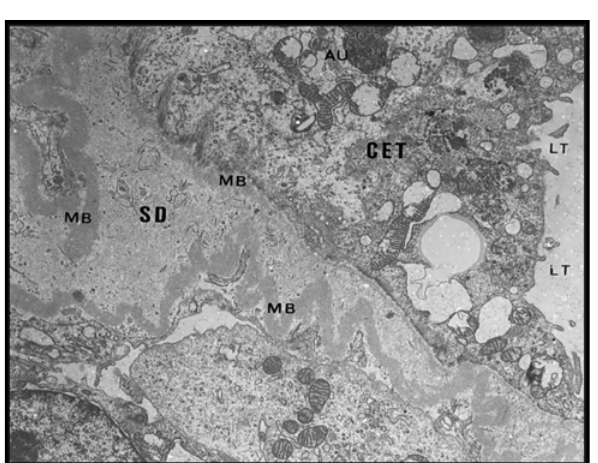
FIGURE 9 - Electronic photomicrography (15.000 X) of proximal tubule from the GI at the time 4 (28 days), demonstrating the presence of autophagolysosomes of debris from condensed necrotic tubular cells, reflecting the phenomenon of apoptosis. Total loss of cellular differentiation with complete atrophy of the board-in-brush, with elongated and tortuous basal membrane. Simplified